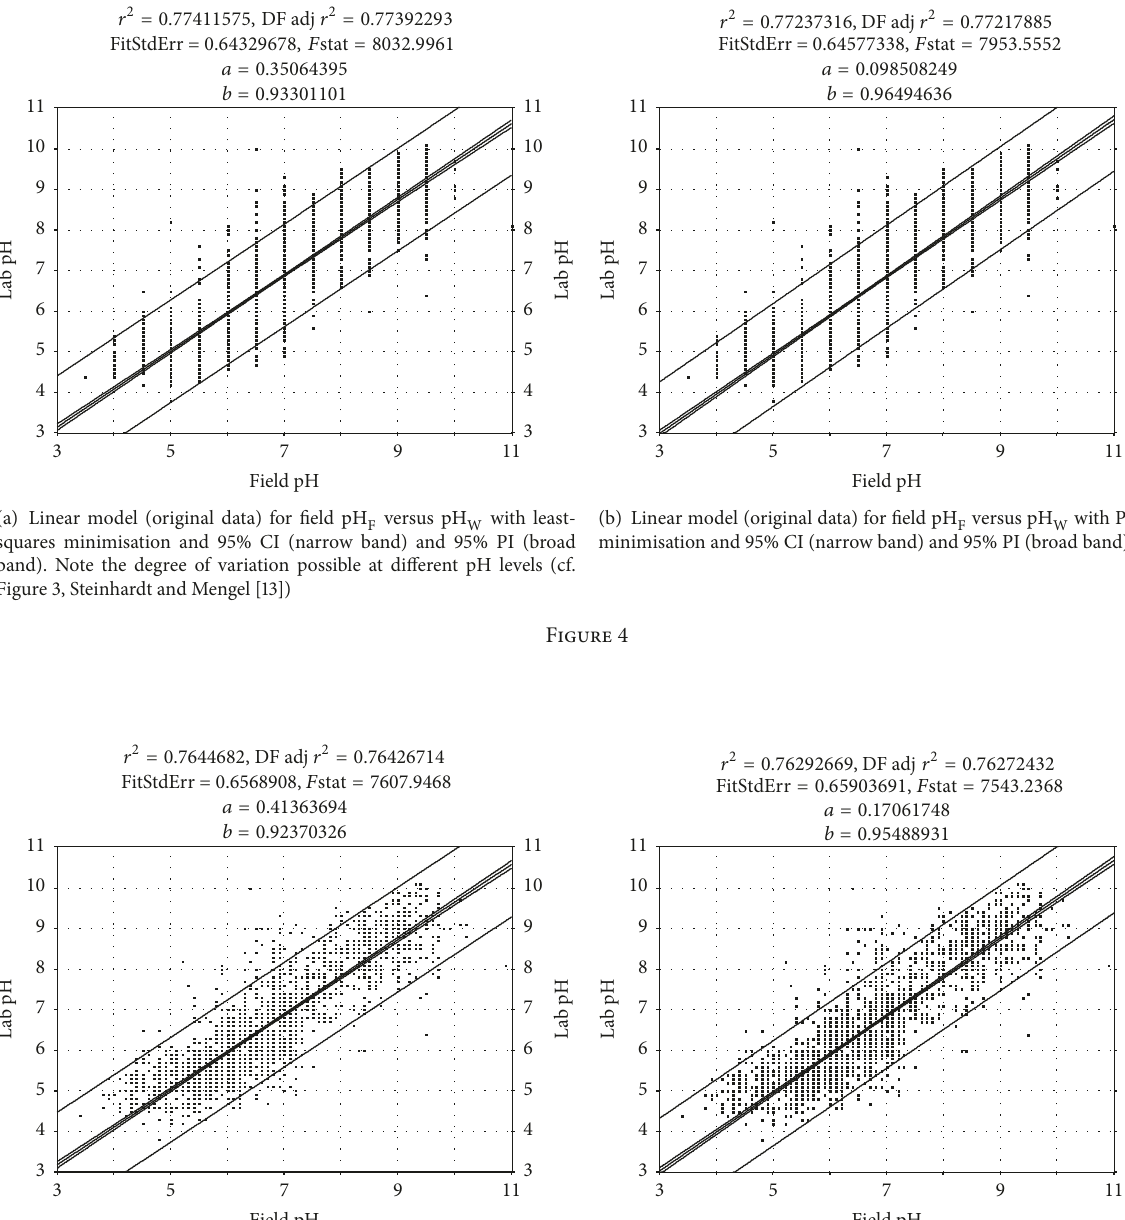
(b) Linear model (randomised data) for field pH F versus pH W with Pearson minimisation and 95 % CI (narrow band) and 95 % PI